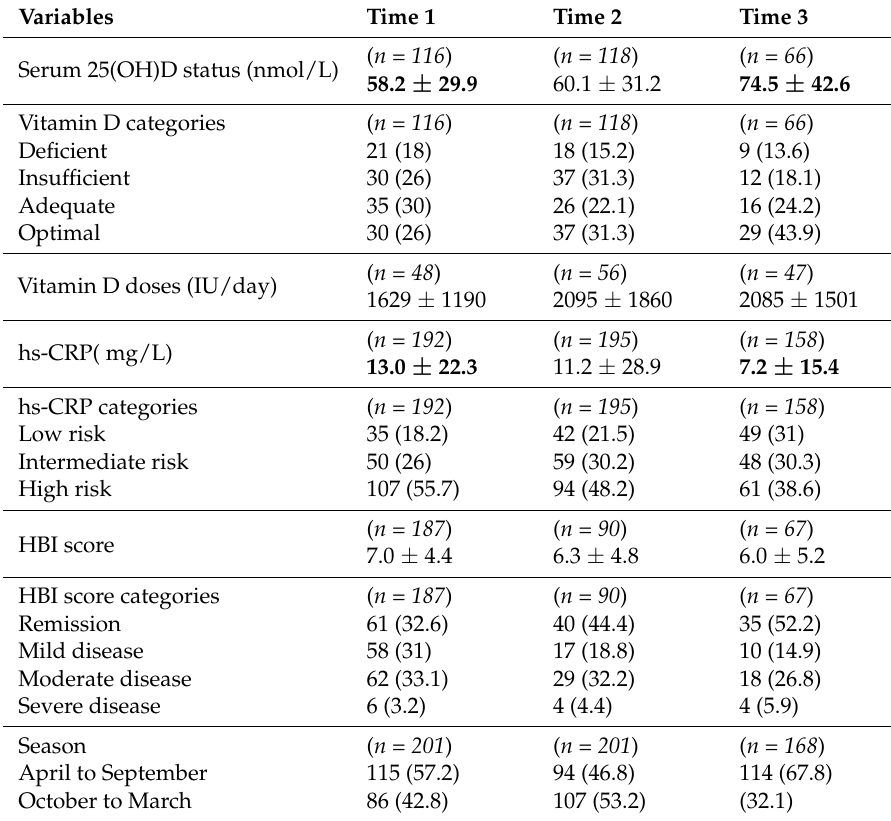
Table 3. Descriptive Characteristics for the Retrospective Cohort Data for Vitamin D Status, Dosage, and Disease Activity